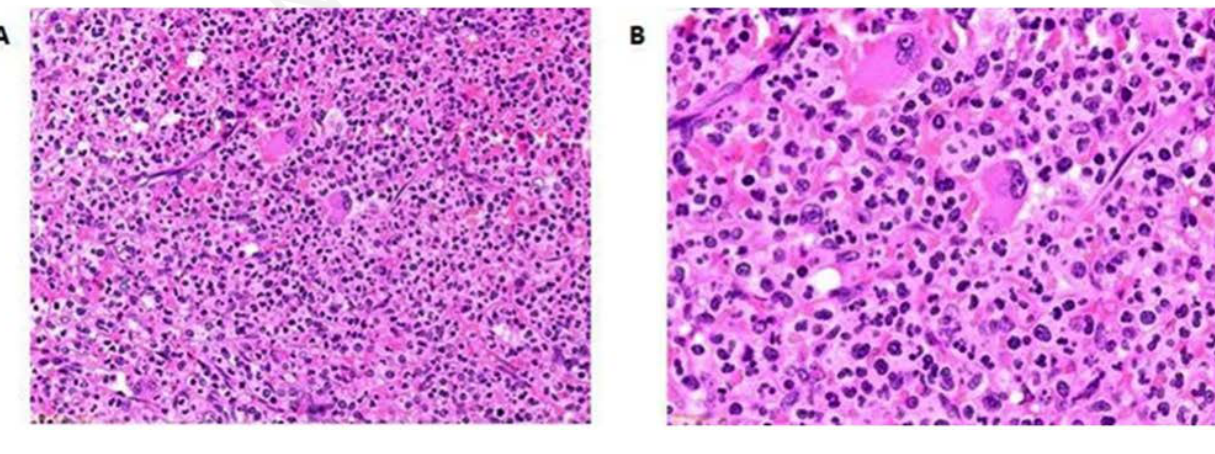
Figure 2. Splenic architectural effacement given by the heterotopic hemopoietic tissue with evident megakaryocytes (Hematoxylin and eosin staining). A) 20X magnification; B) 40X